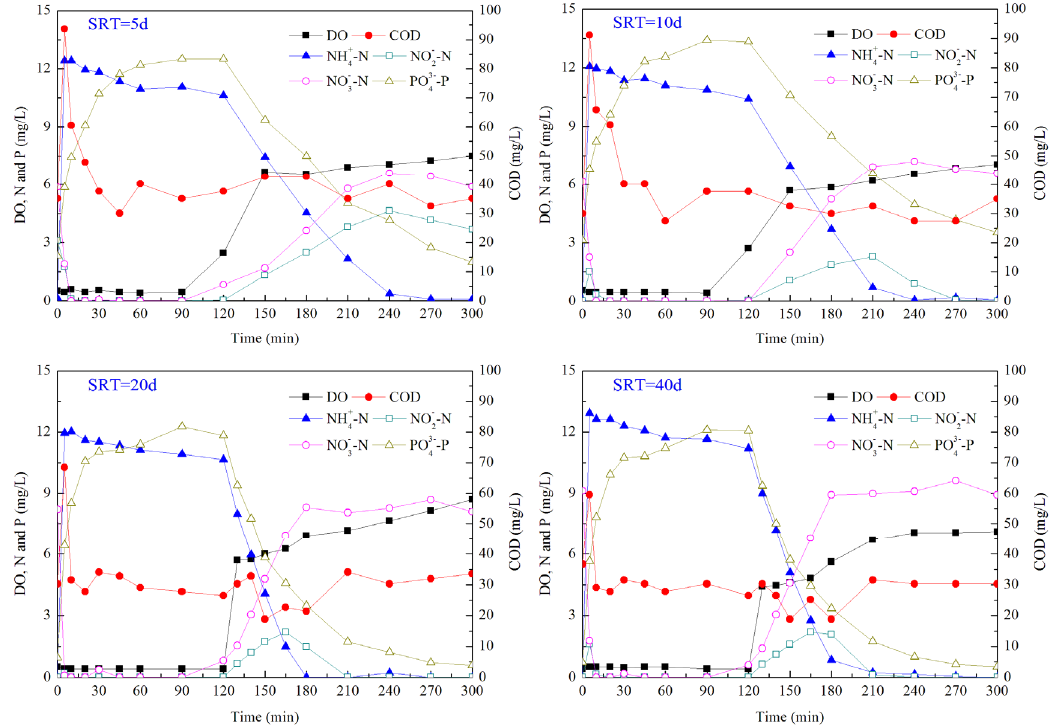
Figure 2. Dynamics of nutrients within a typical SBR cycle at different